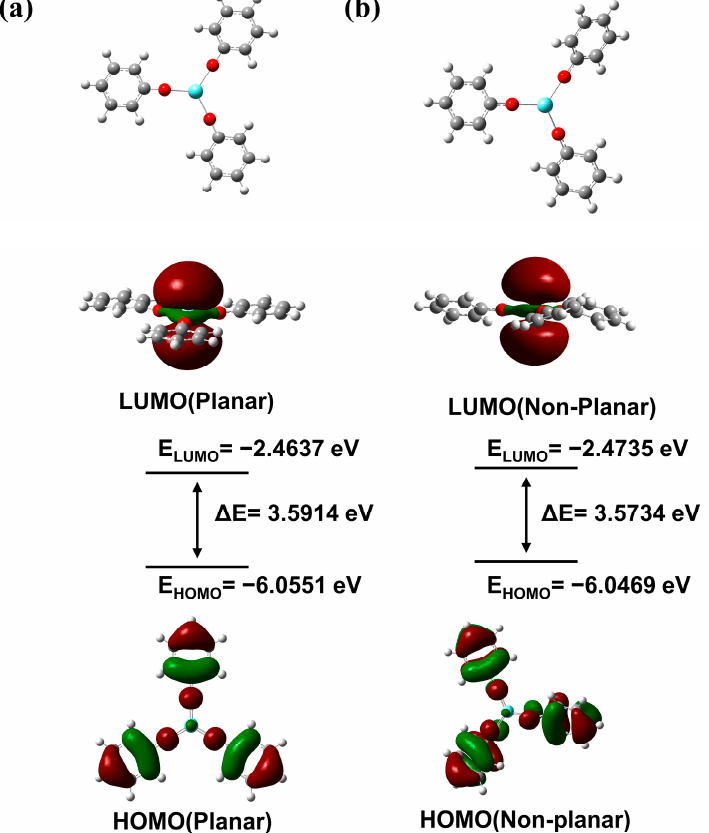
Figure 5. ( a , b ) Planar and nonplanar structures, LUMOs and HOMOs, and energy gaps between LUMO and HOMO of Y(OPh) 3 , respectively. Black: C; red: O; white: H; greenish-blue: Y.